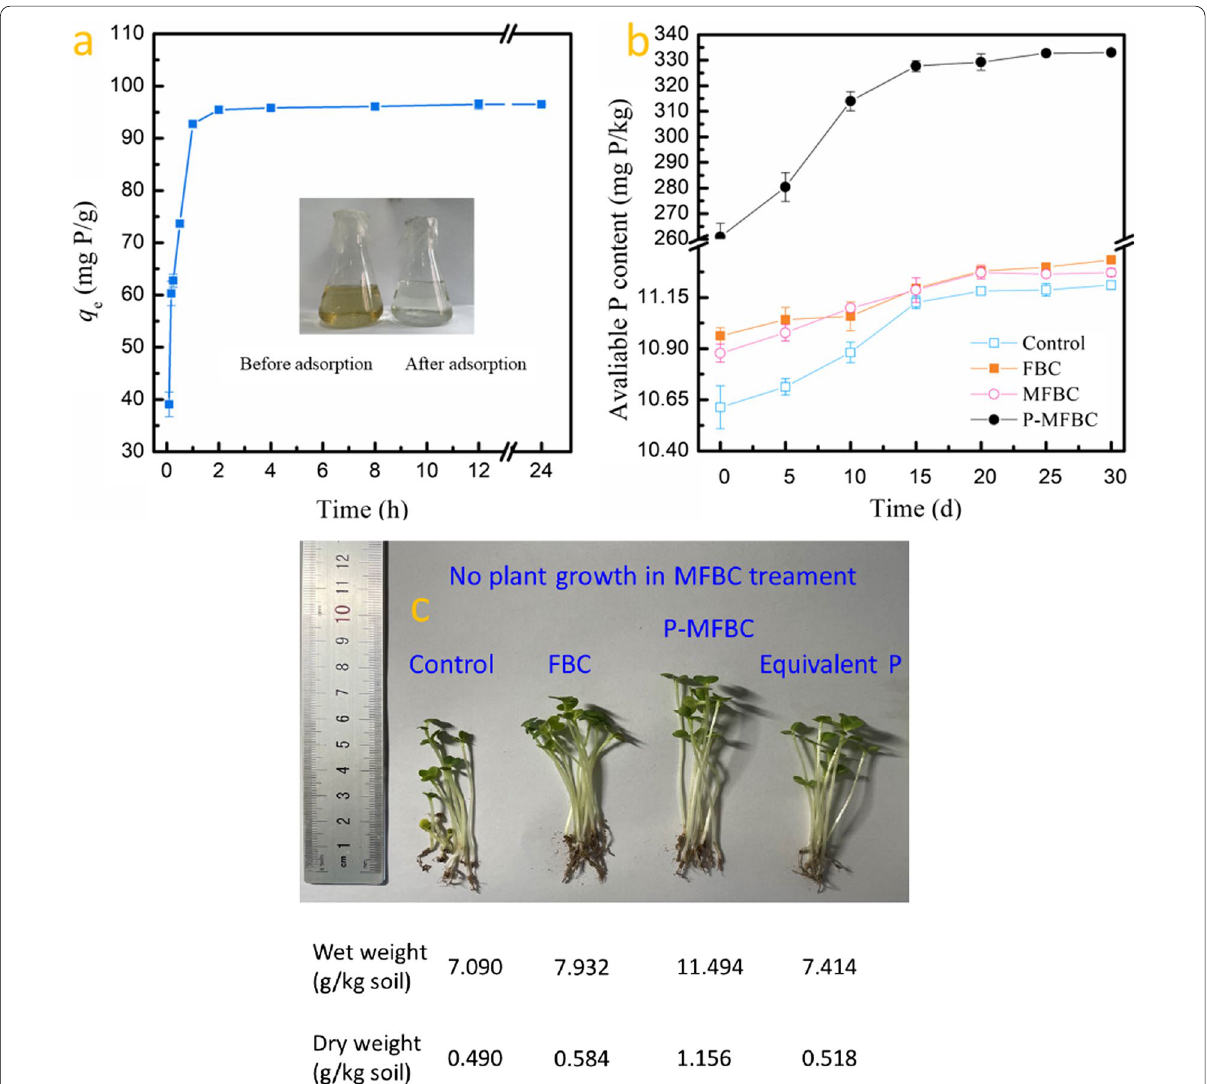
Fig. 7 Effect of contact time on the capture of P from bio-liquid wastewater by the MFBC and model fitting of adsorption kinetics ( a ), release of P in soil ( b ), and potential of P-MFBC to be used as fertiliser for Chinese cabbage growth ( c